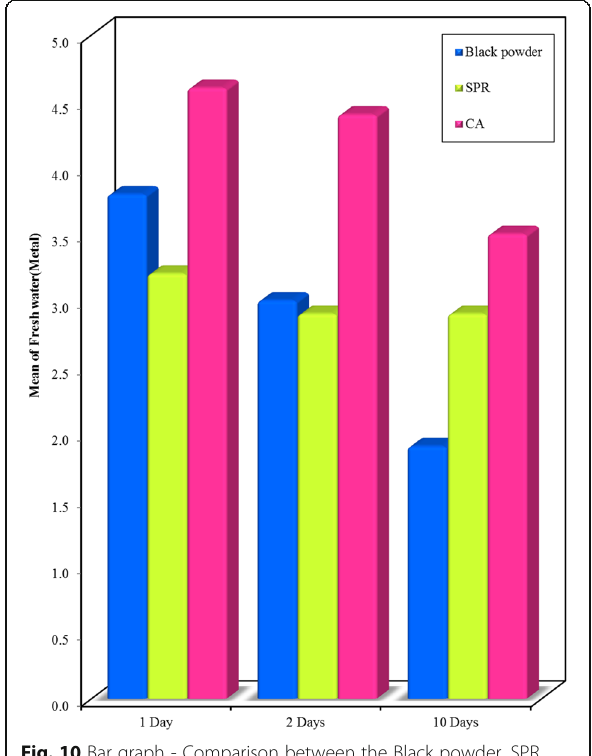
Fig. 10 Bar graph - Comparison between the Black powder, SPR and CA development techniques at different time intervals on metal surface recovered from freshwater . It shows that highest mean visibility score of prints developed using